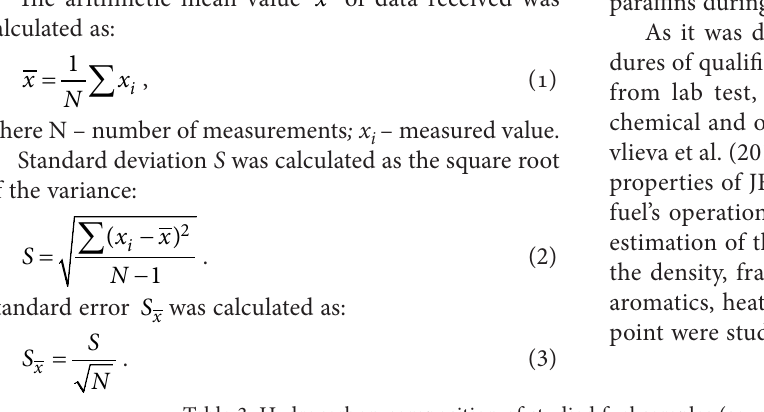
Table 3. Hydrocarbon composition of studied fuel samples (source: author development) Fuel sample n-paraffins,